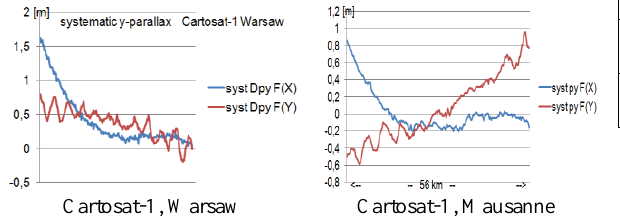
Figure 7. Systematic y-parallaxes of Cartosat-1